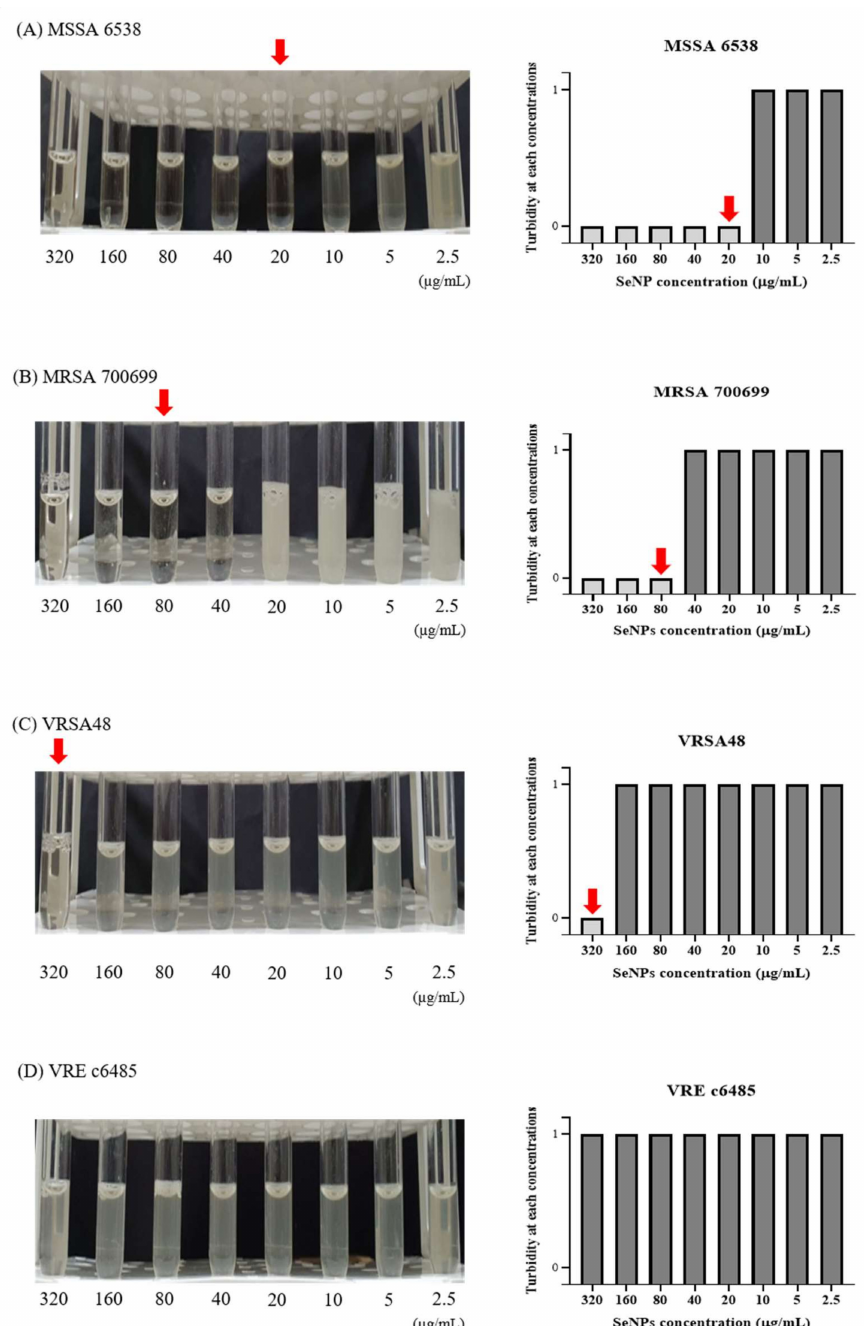
Figure 2. Macro-dilution MIC test for the SeNPs against MSSA, MRSA, VRSA, and VRE. ( A ) S. aureus ATCC 6538 (MSSA), ( B ) S. aureus ATCC 700699 (MRSA), ( C ) VRSA48, and ( D ) VRE c6485. In the 5 mL tube images, from left to right, the concentration of SeNPs was 320 to 2.5 µ g/mL. The MICs were set to a concentration at which bacteria did not grow when viewed with the eye, as indicated by red arrows. In the bar graph, a turbidity value of 1 means that the bacteria have grown, and a turbidity value of 0 indicates that the bacteria have not grown when viewed with the eye. SeNPs showed MIC values of 20, 80, 320, and >320 µ g/mL against MSSA, MRSA, VRSA, and VRE, respectively. Given that the concentration of nanoparticles cannot exceed 320 µ g/mL, the experiments were conducted only for MSSA, MRSA, and VRSA from the subsequent